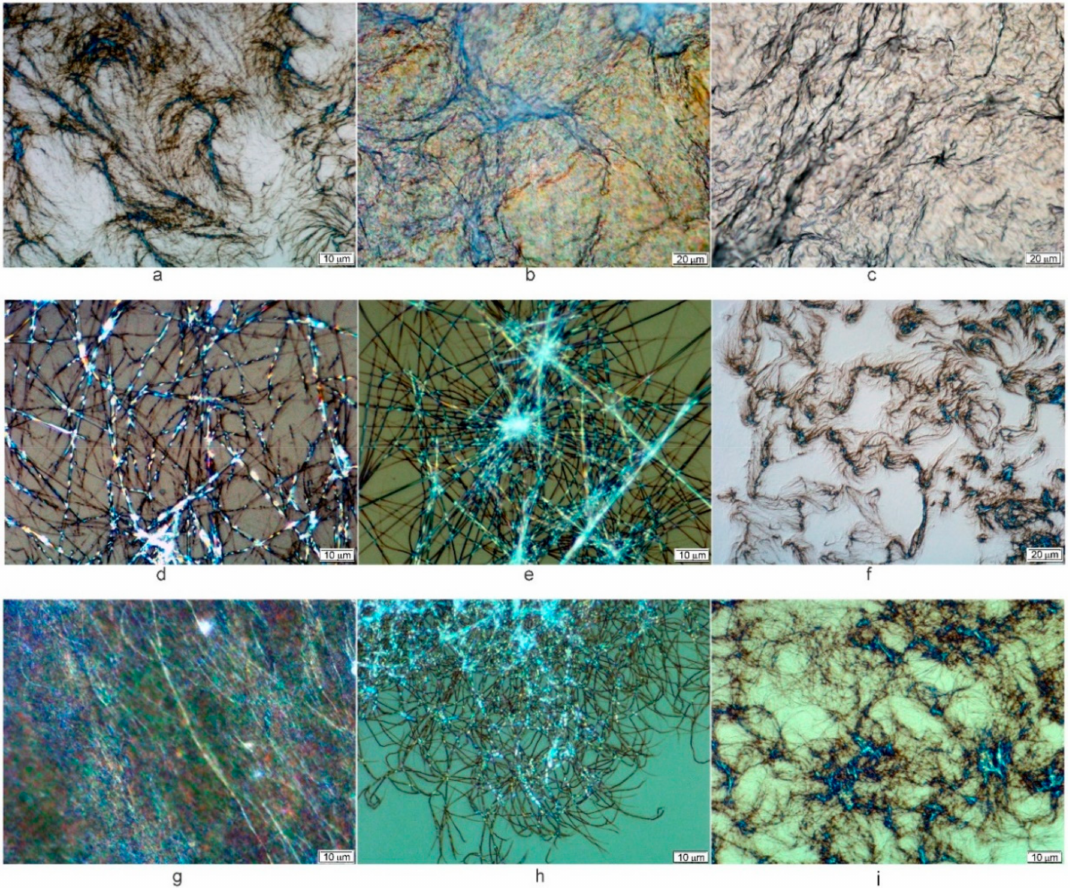
Figure 4. Optical micrographs of the gels formed by several gelators. ( a , b ) compound 6 in EtOH/H 2 O ( v / v 1:1) at 0.74 mg/mL; ( c , d ) compound 7 in DMSO/H 2 O ( v / v 1:1) at 0.91 mg/mL; ( e ) amide 11 in DMSO/H 2 O ( v / v 1:1) at 2.9 mg/mL; ( f ) amide 12 in EtOH/H 2 O ( v / v 1:1) at 2.0 mg/mL; ( g – i ) are the gels formed by compound 13 in: ( g ) water at 0.40 mg/mL; ( h ) DMSO/H 2 O ( v / v 1:1) at 1.0 mg/mL, ( i ) EtOH/H 2 O ( v / v 1:1) at 0.74